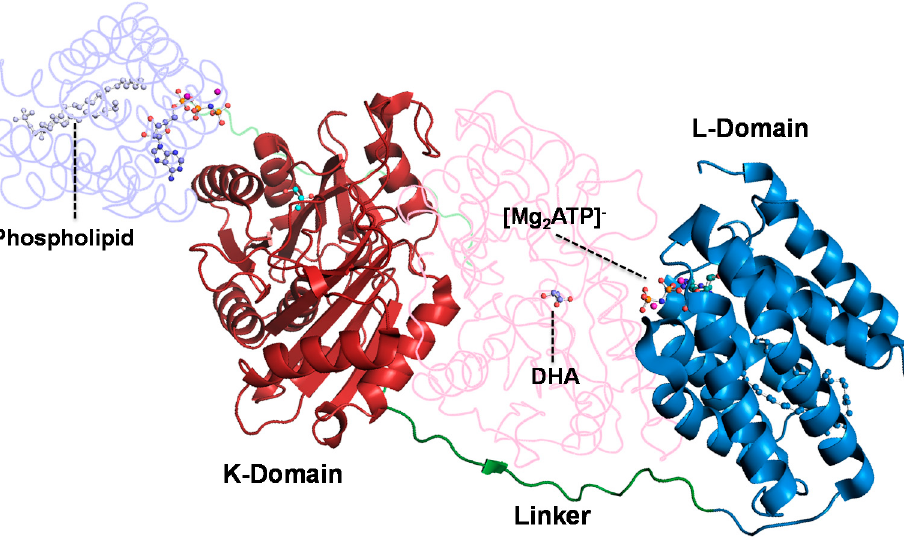
Figure 1. Multi-enzyme system for C–C bond formation catalyzed by DHAP-dependent aldolases, based in the in situ phosphorylation of DHA catalyzed by DHAK from Citrobacter freundii ( C. freundii ). DHA: Dihydroxyacetone; DHAK: dihydroxyacetone kinase; AK: acetate kinase; RAMA: rabbit muscle aldolase; DHAP: dihydroxyacetone phosphate.